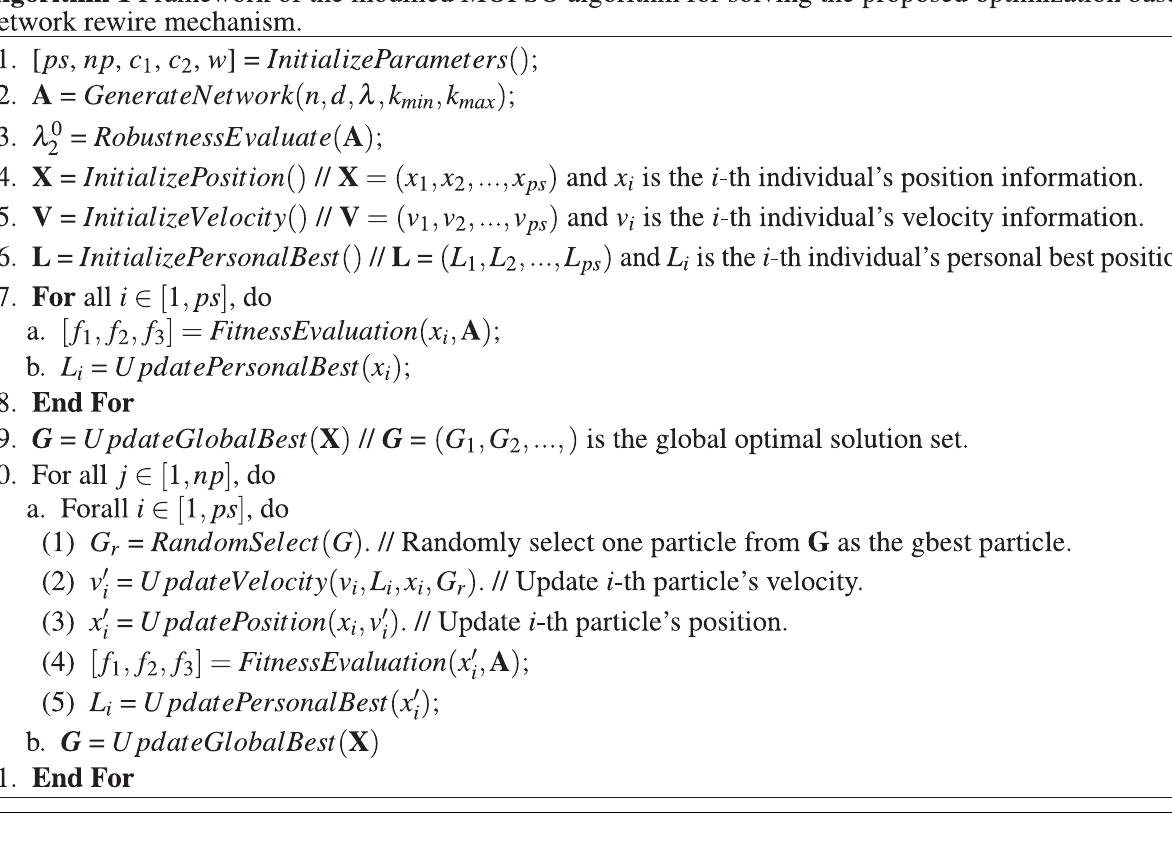
optimization model. Step 10 of Algorithm 1 is the main for loop